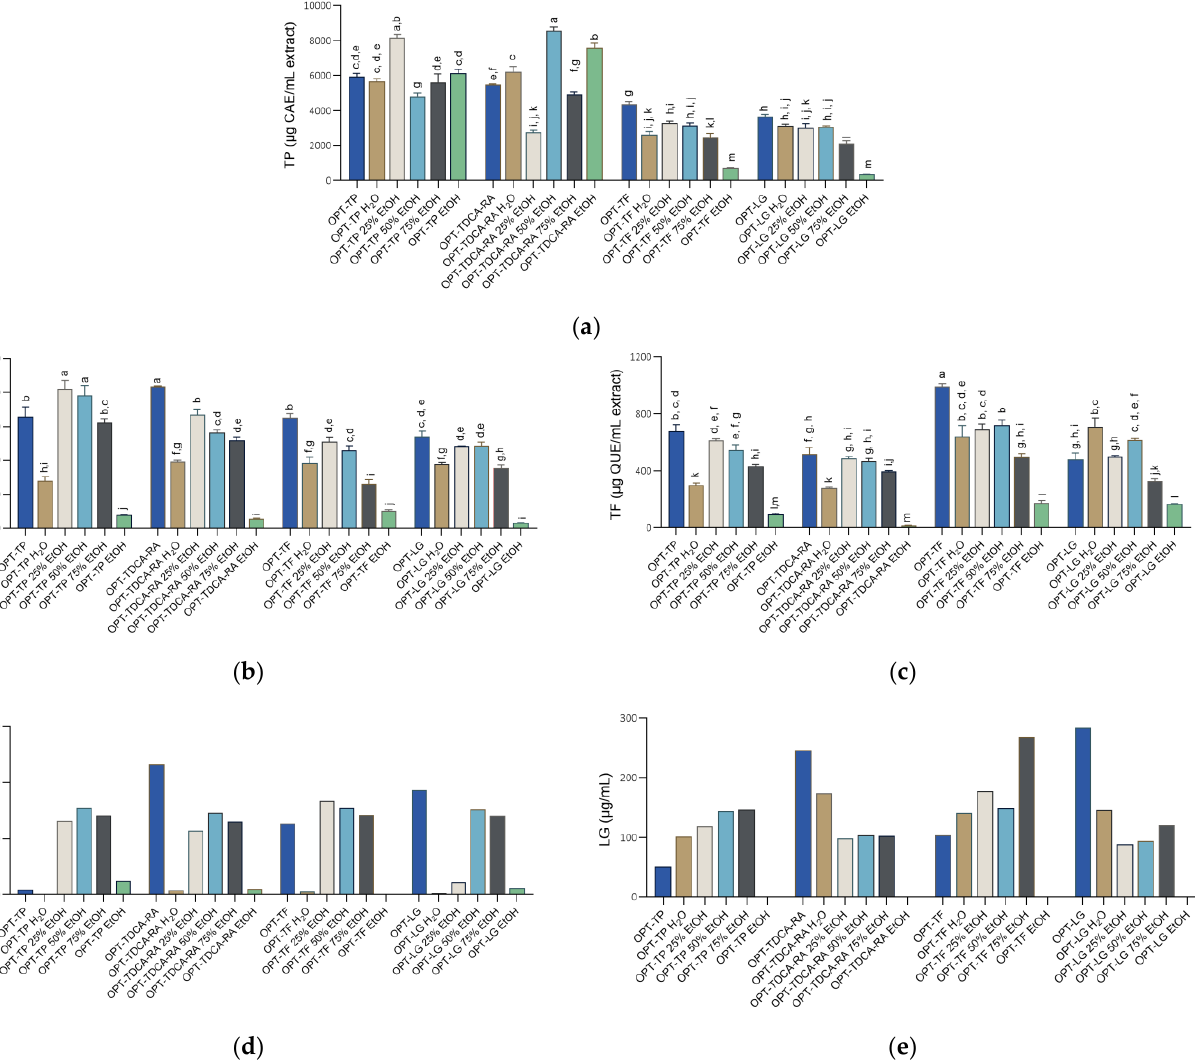
Figure 2. Total ( a ) phenolic (TP), ( b ) dihydroxycinnamic acids (TDCA), ( c ) flavonoids (TF), ( d ) rosmarinic acid (RA), and ( e ) luteolin-7- O -glucoside (LG) content in optimized (OPT-TP, OPT-TDCA-